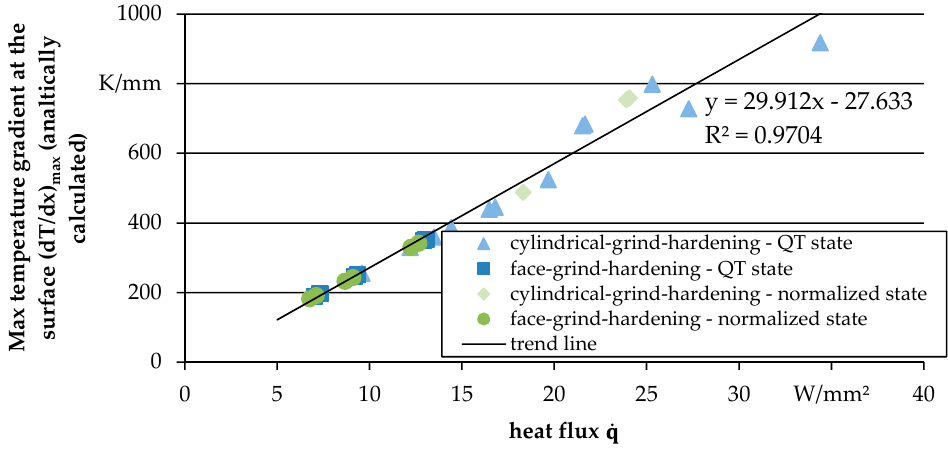
Figure 4. The maximum temperature gradient at the surface (dT/dx) max dependent on the heat flux q(cid:4662) .